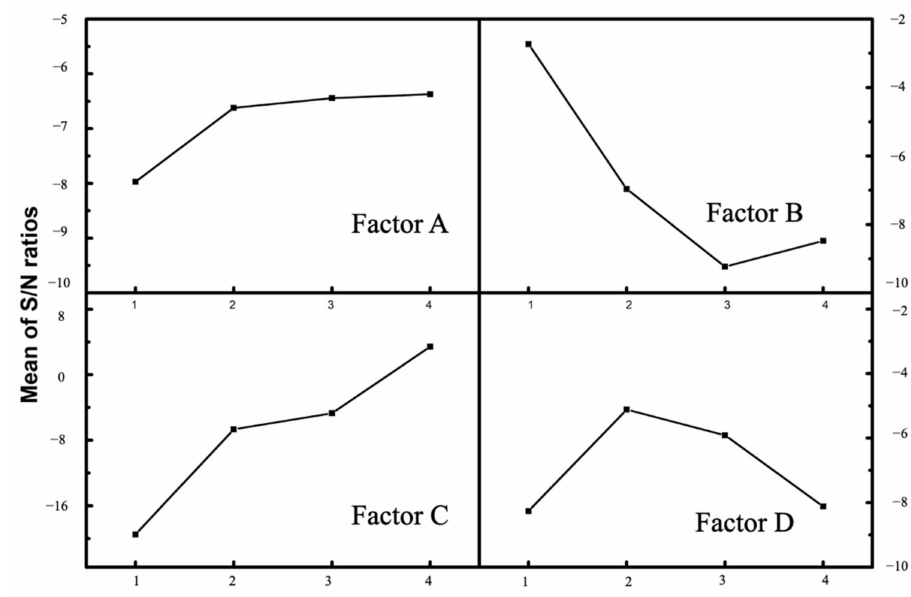
Figure 1. S / N ratio plots for the effects of experimental parameters for citric